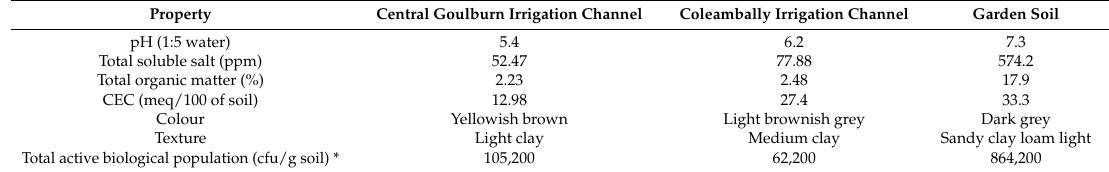
Table 3. Properties of the sediment used in the experiment. CEC = Cation exchange capacity.